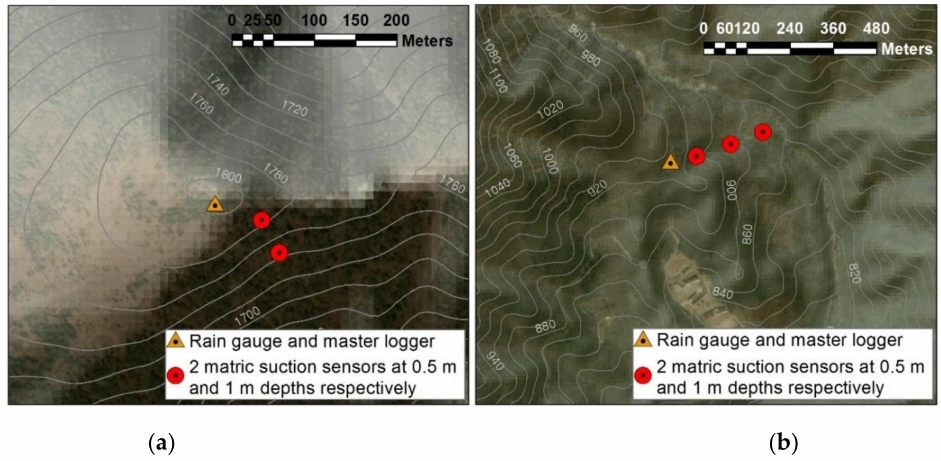
Figure 8. Overview of the Jirisan landslide monitoring sensor layout: ( a ) Jeseokbong station; ( b ) Jungsalli